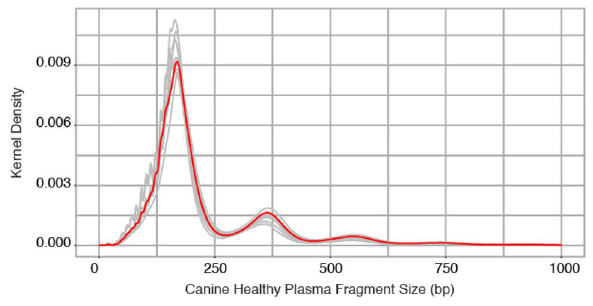
Figure 1. Plasma cell-free DNA fragment size (base pairs) in nine healthy dogs. Individual samples are shown in grey, all samples combined are shown in